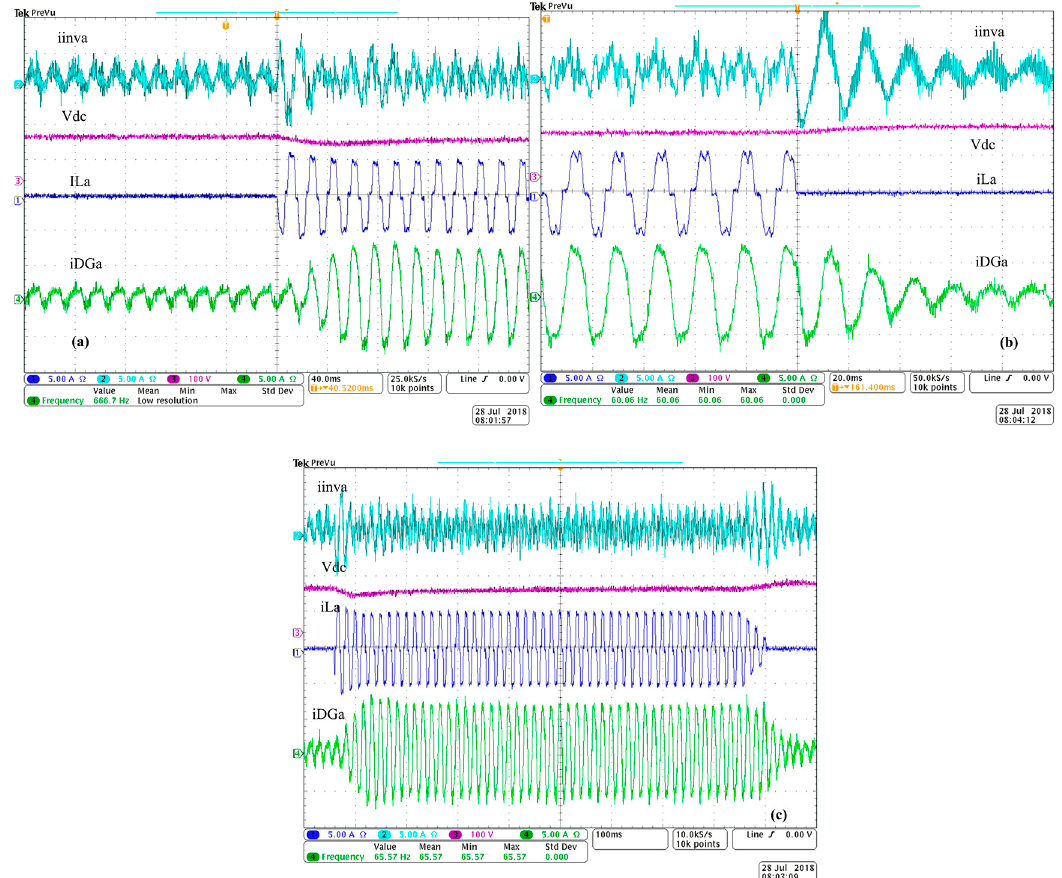
Figure 13. Dynamic performance under sudden variation of: ( a ) balanced RL nonlinear load, ( b ) balanced RC nonlinear load, and ( c ) under switching on and off of RL nonlinear load. The performance of DC-link voltage ( V dc ), battery current ( i bat ), load current ( i La ) and